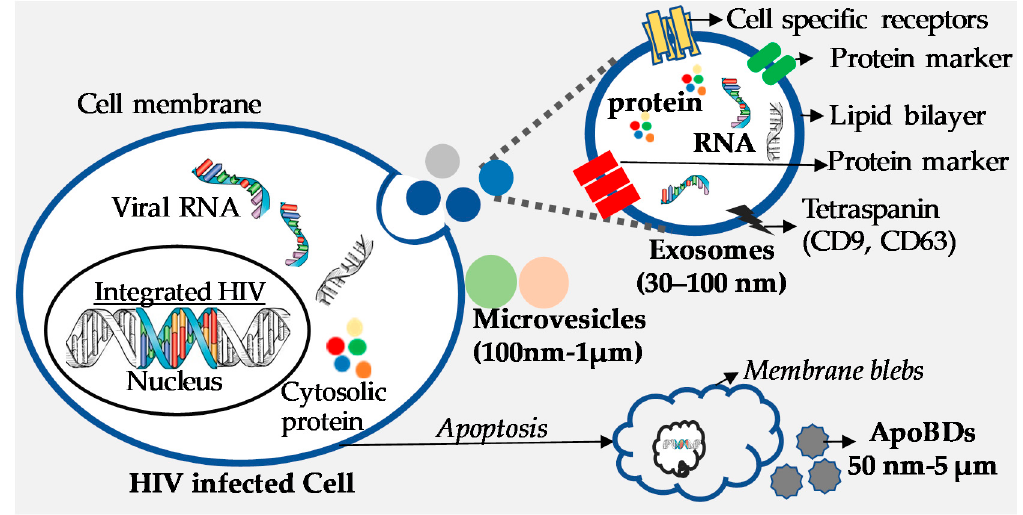
Figure 1. Extracellular vesicles (exosomes, microvesicles, and apoptotic bodies) secreted from HIV-infected cells. Exosomes (30 nm–100 nm) contain proteins, nucleic acids (RNA), and lipids.